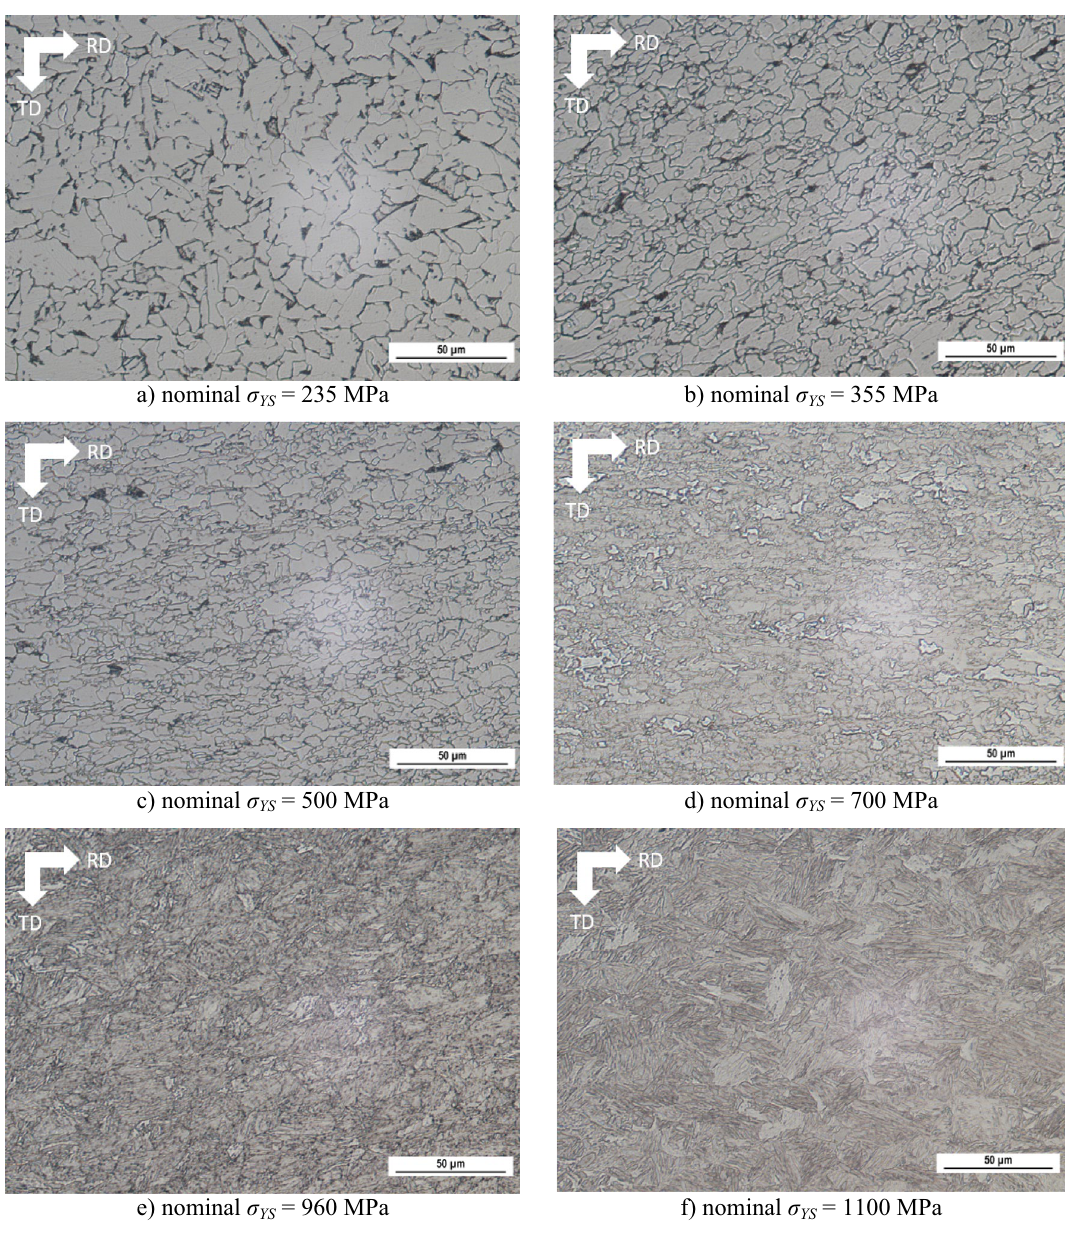
Figure 3. Metallographic